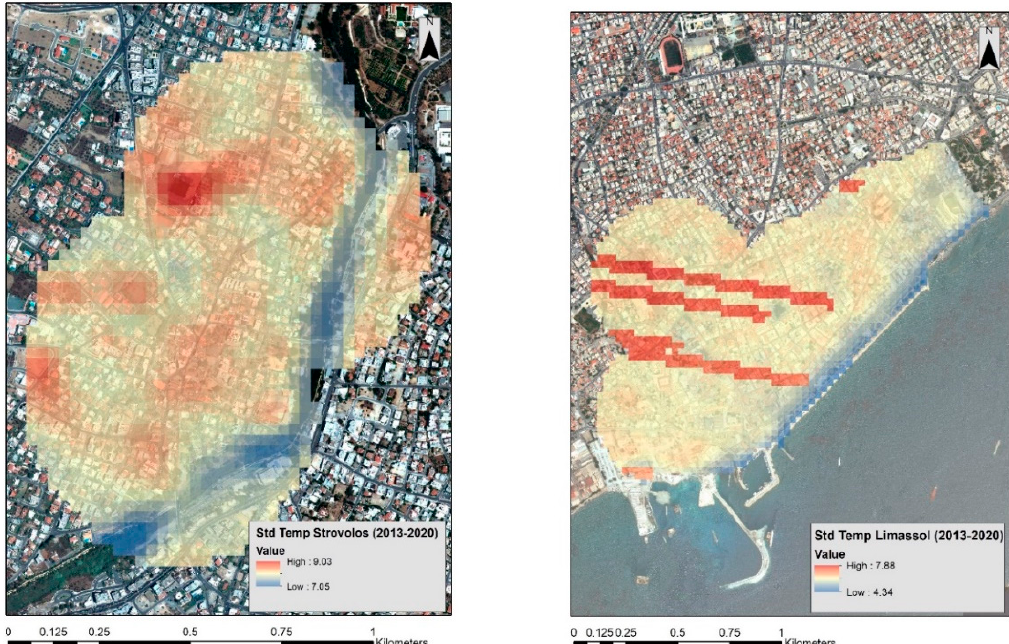
Figure 5. ( Left ) Standard deviation temperature over the Strovolos area between the years 2013 and 2020. ( Right ) Standard deviation temperature over the Limassol area between the years 2013 and 2020. Higher standard deviation is visualised with red colour while lower min temperatures are visualised with blue colour.